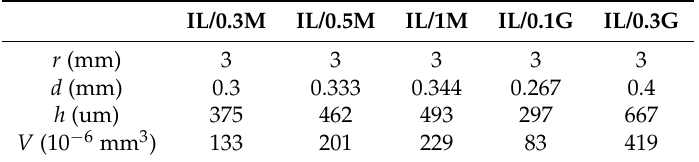
Table 1. Wear volume ( V ) of the steel ball sliding with different IL composite films. IL/0.3M IL/0.5M IL/1M IL/0.1G